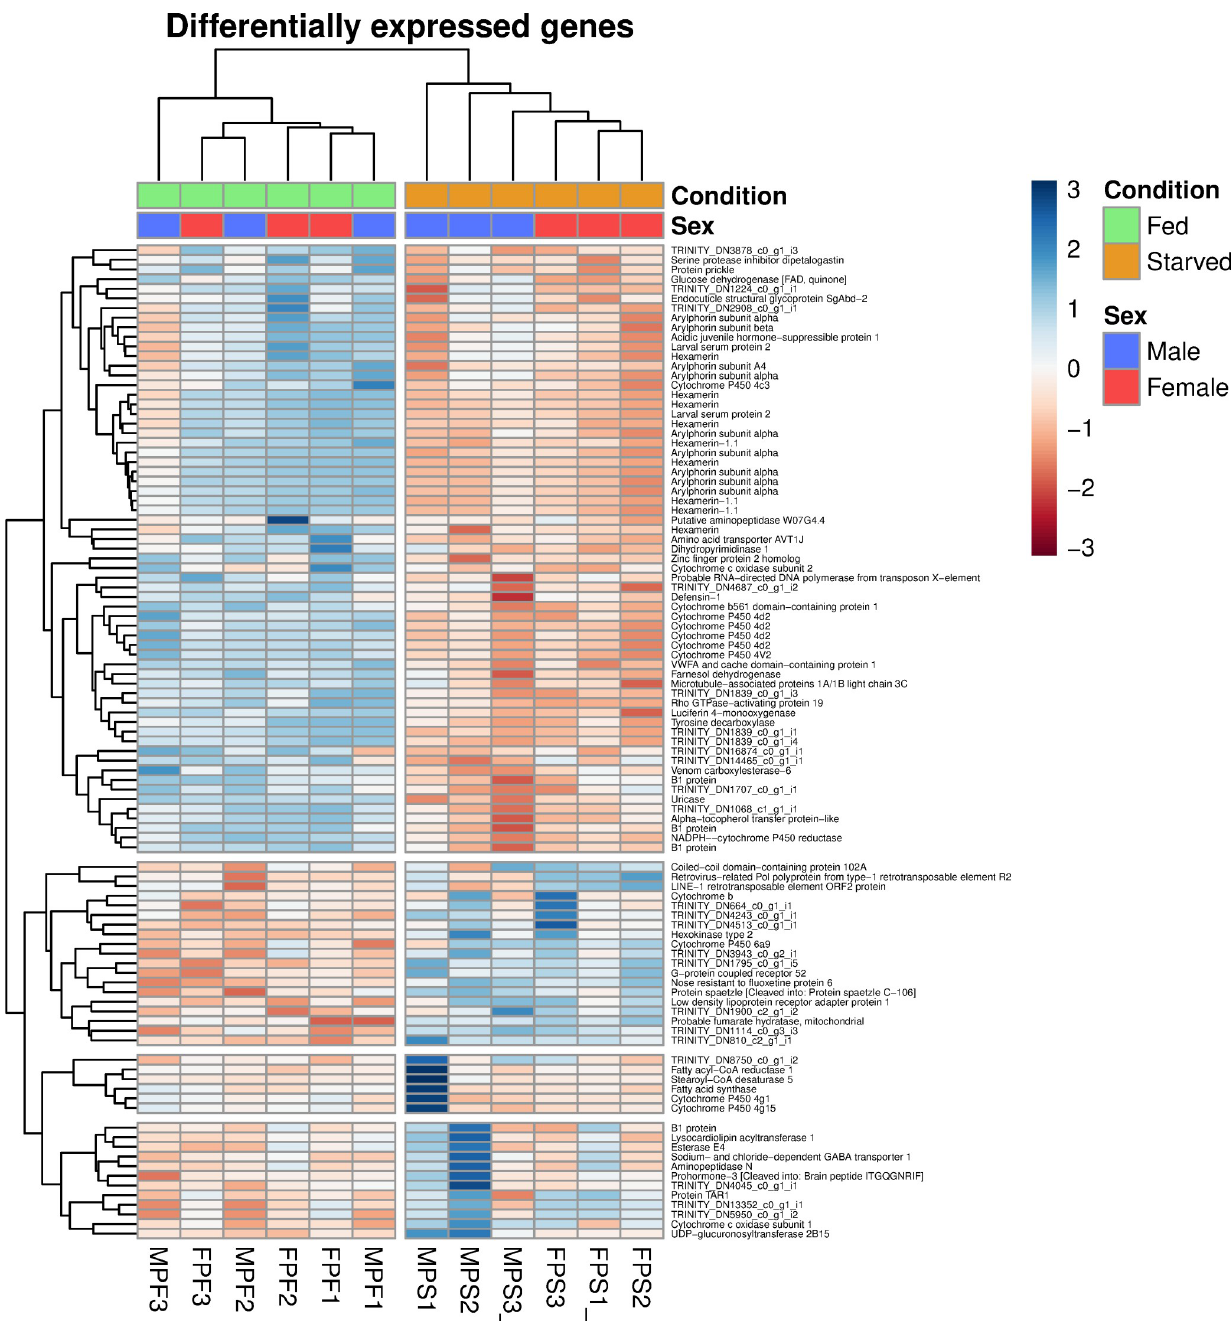
Fig 4. Heatmap of differentially expressed genes. The expression levels are quantified as log-transformed counts-per-million. The names of the genes were obtained from the annotation with the NCBI database. https://doi.org/10.1371/journal.pone.0255660.g004 pustulatus . The presence of these transcripts in the current N . pustulatus transcriptome is simi- lar to contaminant sequences found in the transcriptome assemblies of other Coleoptera spe- cies annotated using BLAST and similar databases. Roughly 10% of the hits obtained during transcriptome annotation of the seed beetle, Callosobruchus maculatus , belonged to viruses,